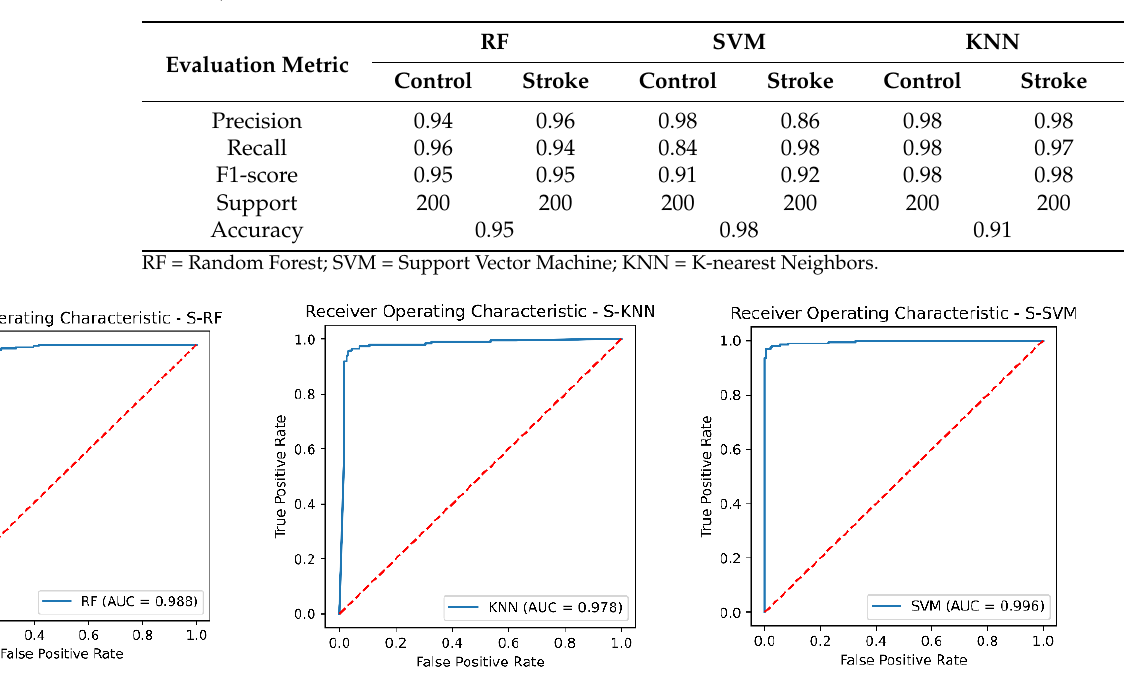
Figure 7. The receiver operating characteristic curves (ROC) of the three classification models with Borderline-SMOTE; Subfigure ( left ) shows the ROC of the classifier Random Forest; Subfigure ( center ) shows the ROC of the classifier Support Vector Machine; Subfigure ( right ) shows the ROC of the classifier K-nearest neighbor.